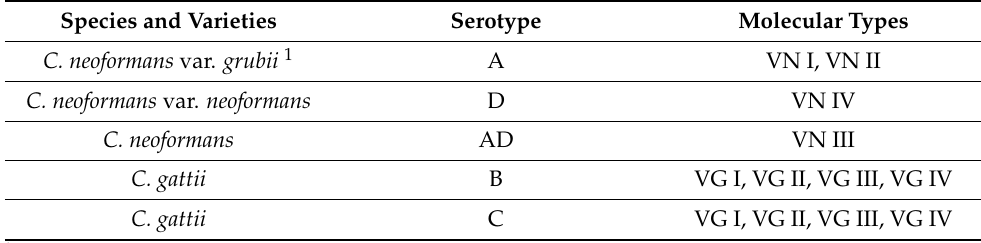
Table 1. Classification of Cryptococcus